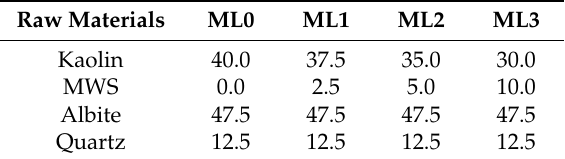
Table 2. Compositions of the floor tile formulations (wt. %).